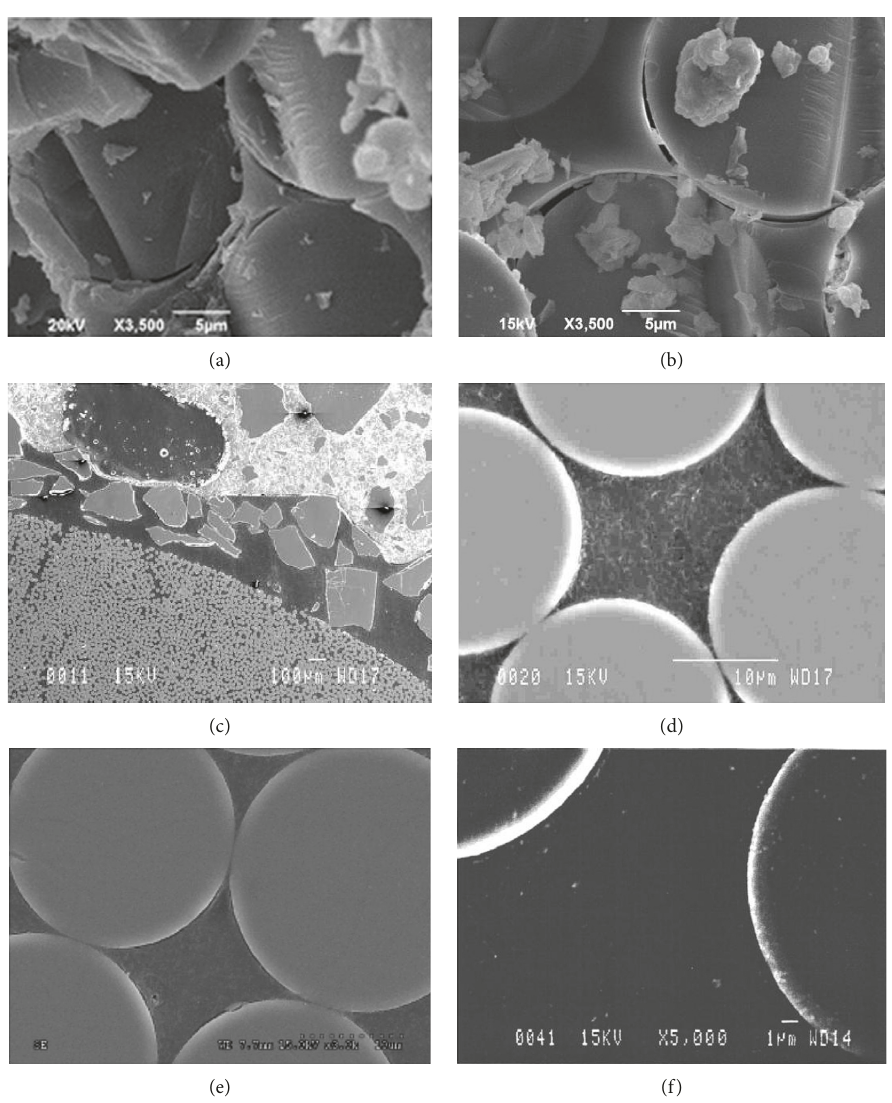
Figure 17: Micrograph of conditioned GFRP reinforcing bar with no damage. (a) Adapted from [10]. (b) Adapted from [11]. (c) Adapted from [13]. (d) Adapted from [14]. (e) Adapted from [27]. (f) Adapted from